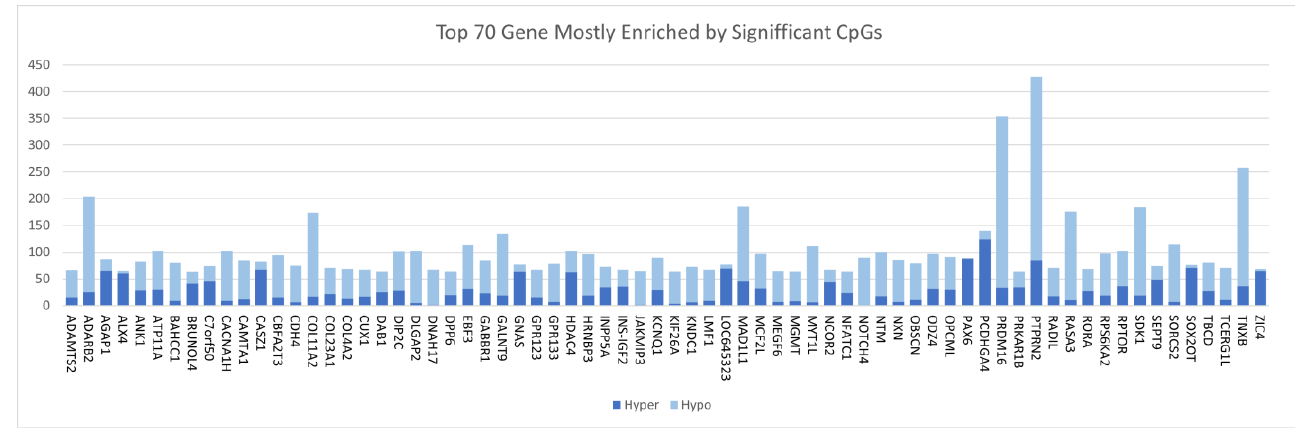
Figure 2. The 70 most highly methylated genes. The number of methylation sites is plotted on the y axis and the gene names are plotted on the x axis. axis and the gene names are plotted on the x